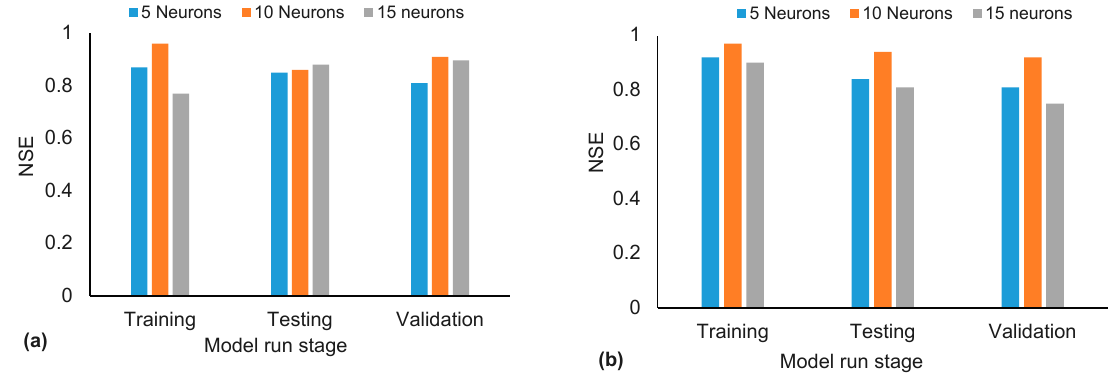
Figure 9. Comparison of the ANN results for 5, 10, and 15 hidden neurons in each layer: ( a ) two-layer architecture, ( b ) three-layer architecture.